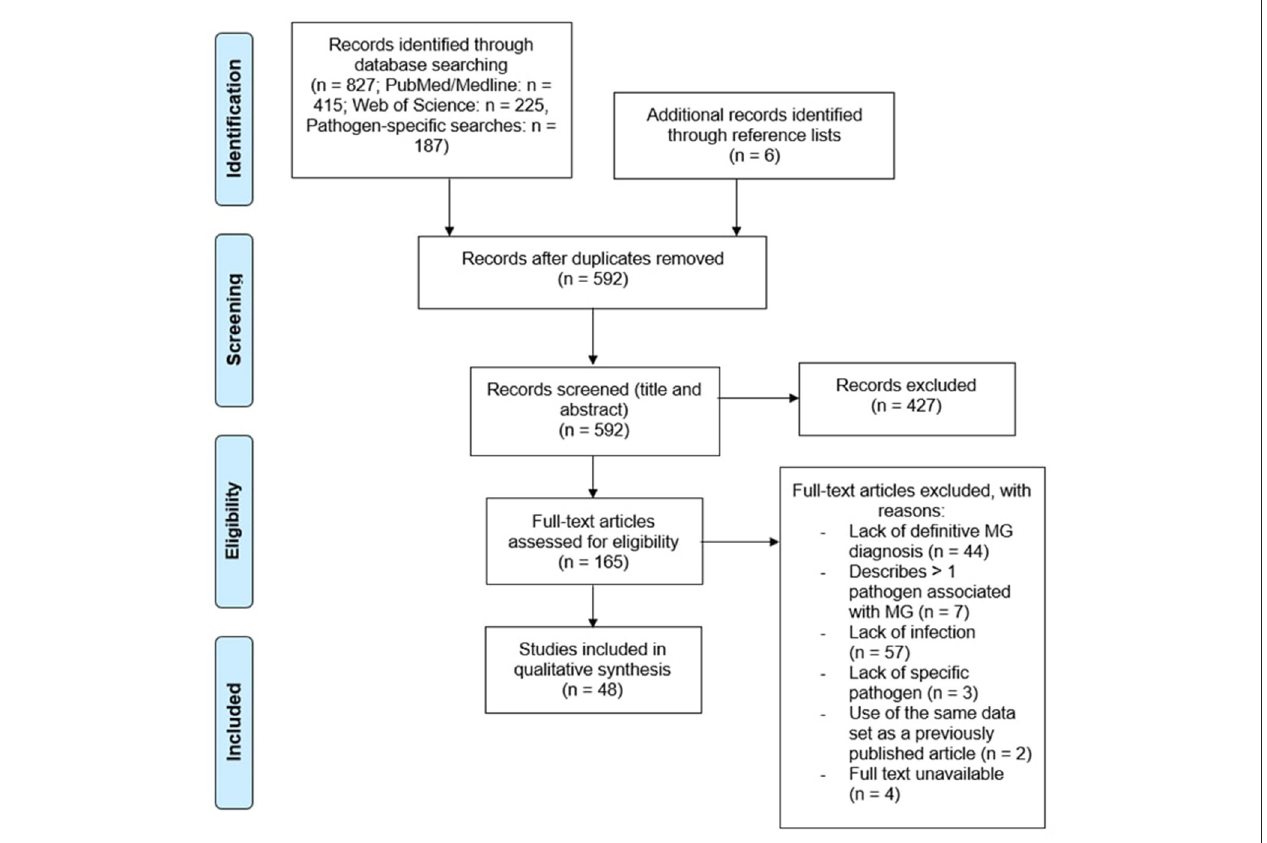
FIGURE 1 | Curation of records. Papers captured by search algorithms in PubMed and Web of Science ( n = 827) were manually curated to remove duplicates ( n = 592). Papers were screened to assess whether they met the inclusion and exclusion criteria, yielding a total of 48 publications. An additional 6 papers were retrieved from the reference lists of relevant